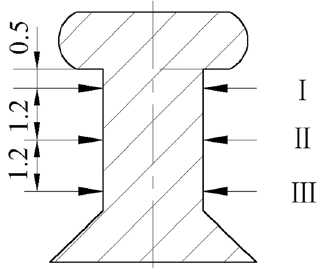
Figure 10. The measuring positions.